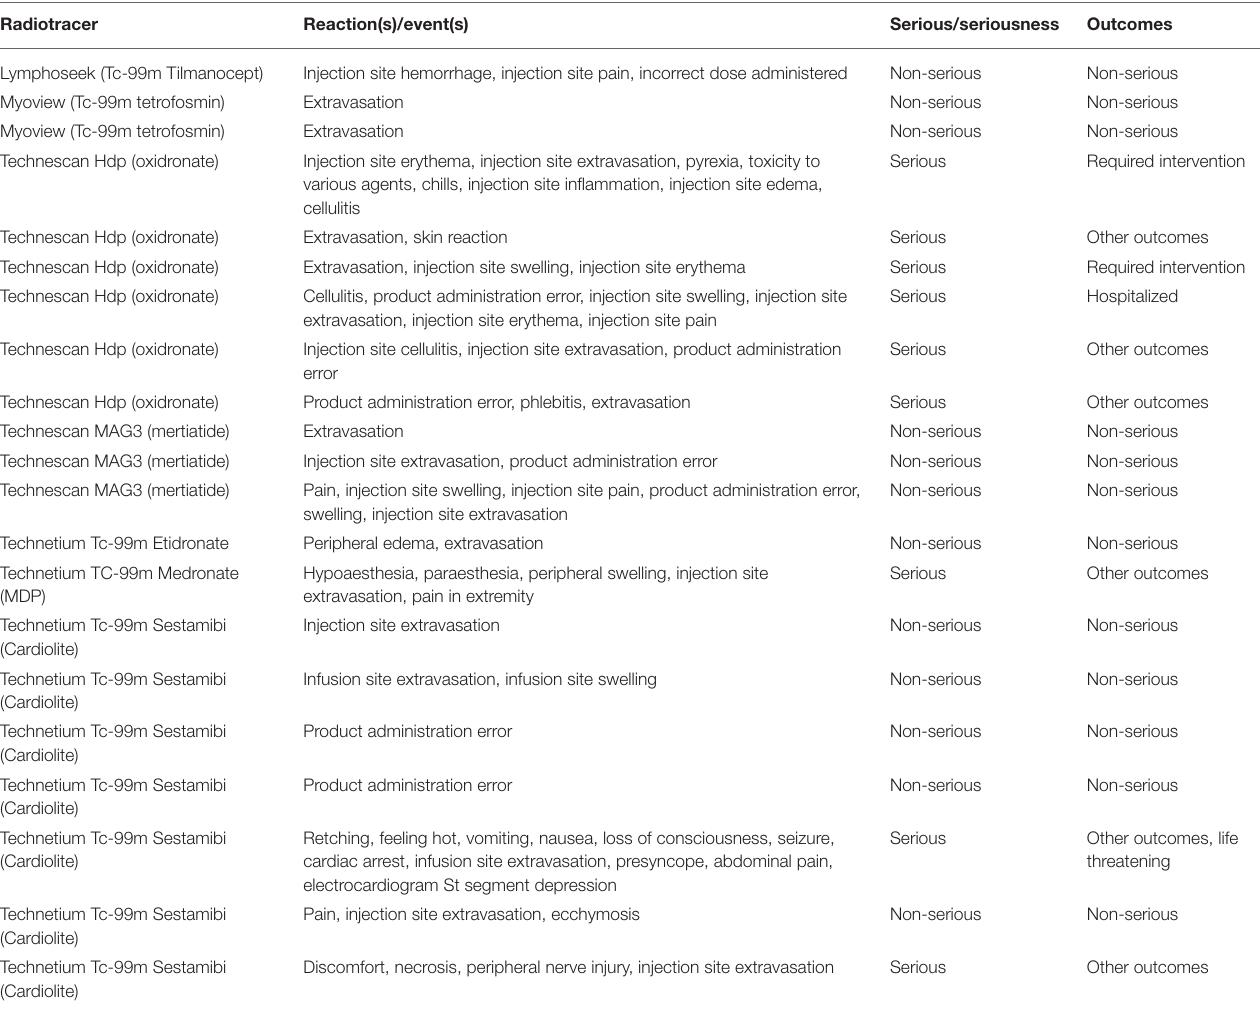
TABLE 1 | FAERS listing of cases.